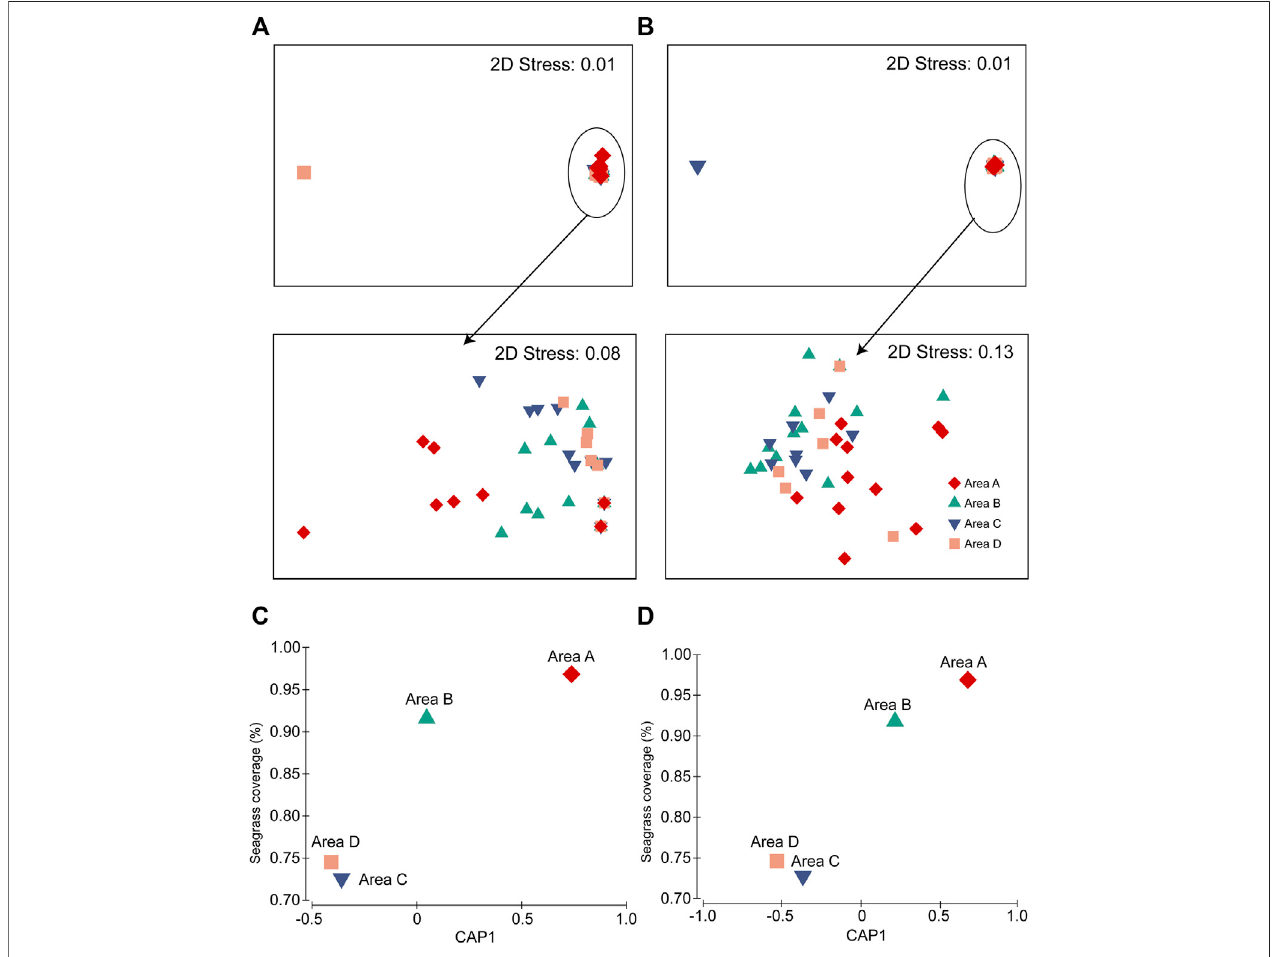
FIGURE 6 | Differences in fi sh assemblages among the four areas A – D: (A) BS methodand (B) UVC method. CAP plot showing the correlation between seagrass coverage (%) and fi sh abundance: (C) BS method and (D) UVC method.